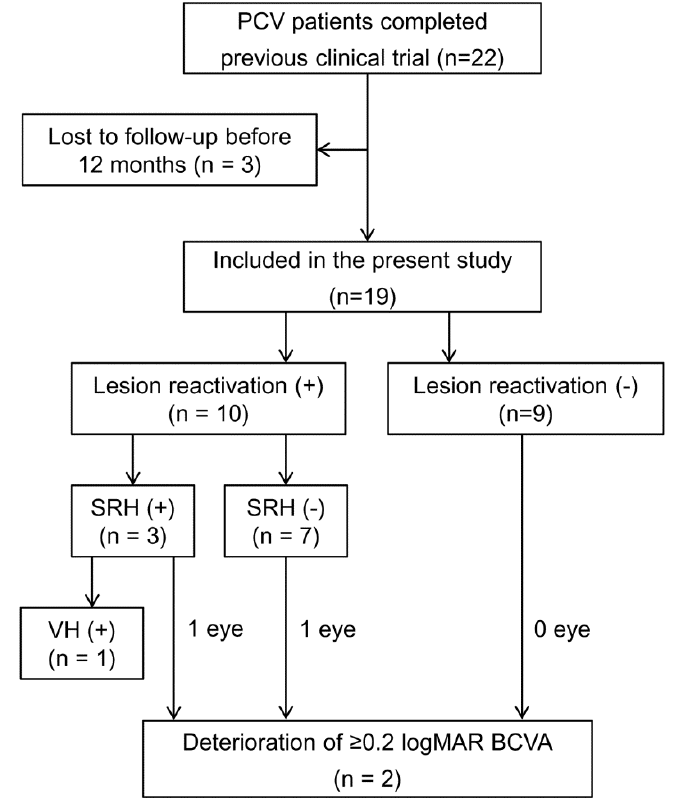
Figure 1. Clinical course in the included eyes. BCVA = best-corrected visual acuity; logMAR = logarithm of minimum angle of resolution; PCV = polypoidal choroidal vasculopathy, SRH = subretinal hemorrhage, VH = vitreous hemorrhage. The baseline was 56 weeks after fixed-dose therapy. The mean logMAR BCVA was 0.26 ± 0.34 at baseline, 0.29 ± 0.38 at 12 months, and 0.31 ± 0.38